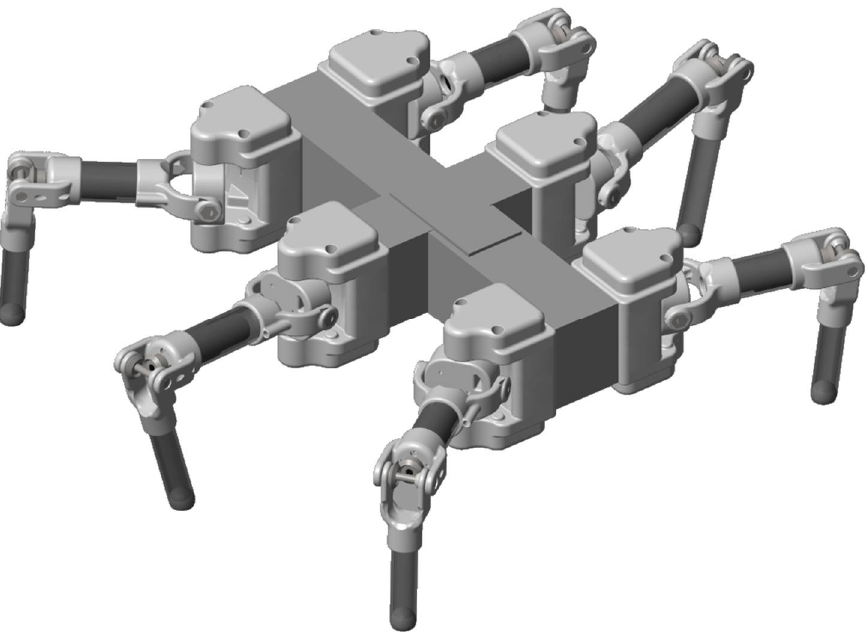
Figure 7. Structural design of the robot after the two-step optimization.